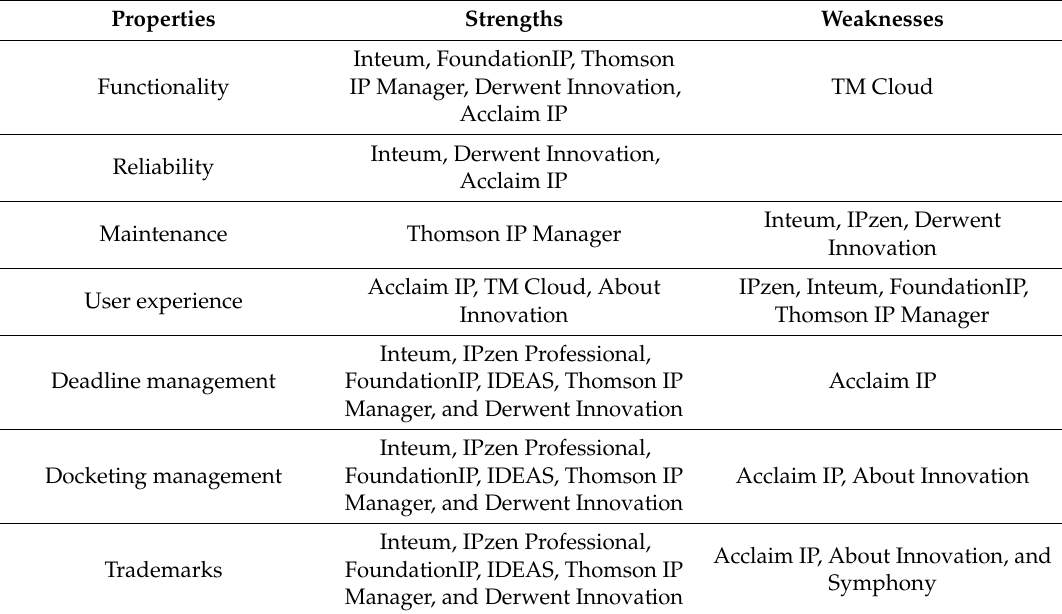
Table 3. Evaluation of SW solutions within a qualitative